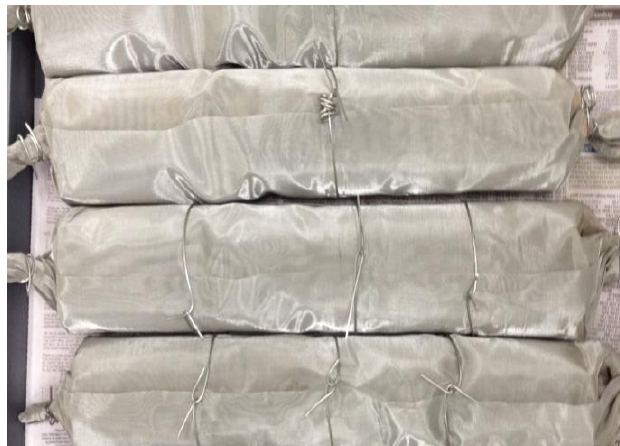
Figure 1. Stainless-steel mesh rolls with biosolids inside.